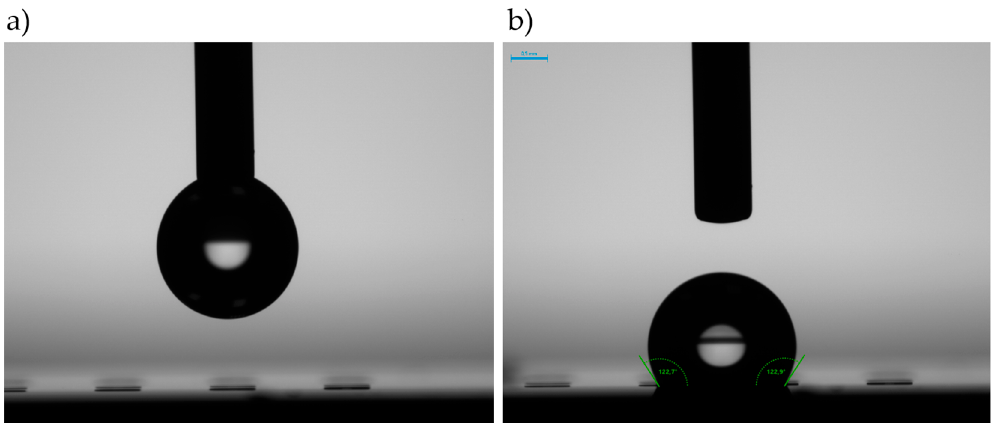
Figure 21. ( a ) Droplet above the photoresist barriers; ( b ) droplet after placement on the hydrophobic structures.